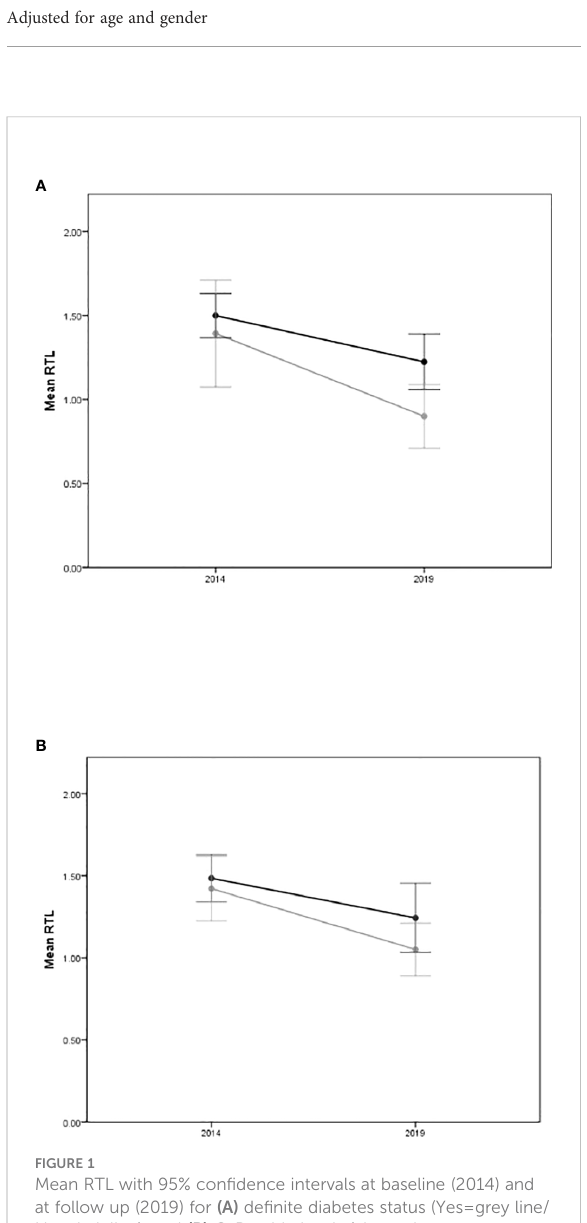
FIGURE 1 Mean RTL with 95% con fi dence intervals at baseline (2014) and at follow up (2019) for (A) de fi nite diabetes status (Yes=grey line/ No=dark line), and (B) C-Peptide levels (above the mean=grey line/below the mean=dark